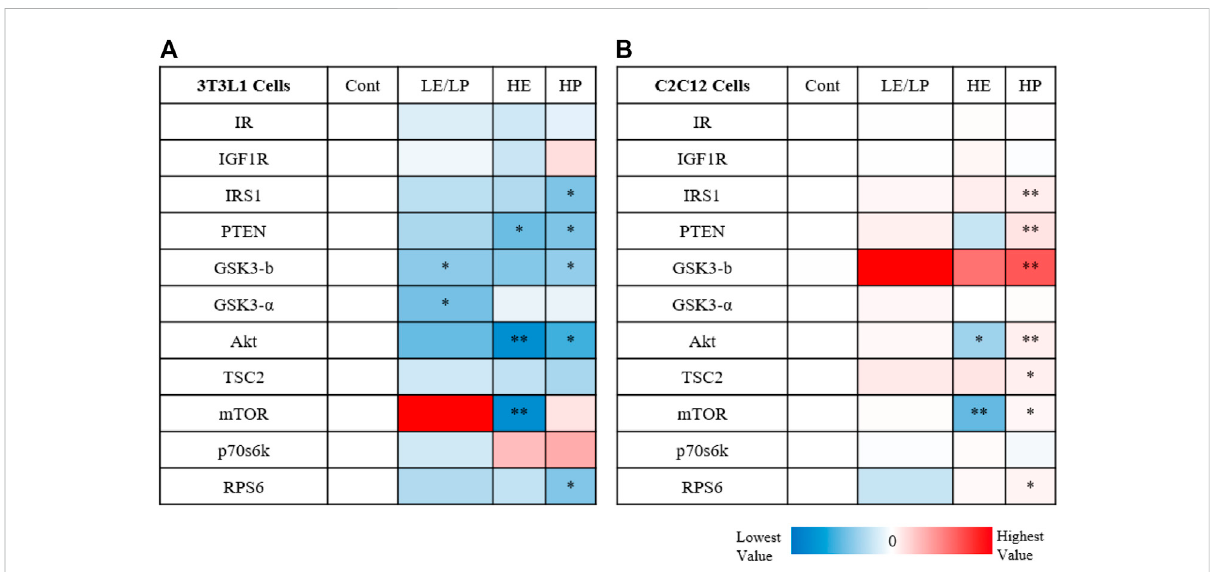
FIGURE 4 Heatmap illustrating the activity of insulin signaling phosphoproteins in response to 10% of sera from different athlete groups (LE/LP: low endurance/low power, HE: high endurance, and HP: high power) in 3T3-L1 cells (A) and C2C12 (B) . The dark red color marks the highest increase in phosphoprotein activity between the treatment (serum group) and the control, while the deep blue color represents the lowest decrease in phosphoprotein activity between the treatment (serum group) and control. Statistical signi fi cance was determined by one-way ANOVA followed by independent sample t -test (* p ≤ 0.05, ** p ≤